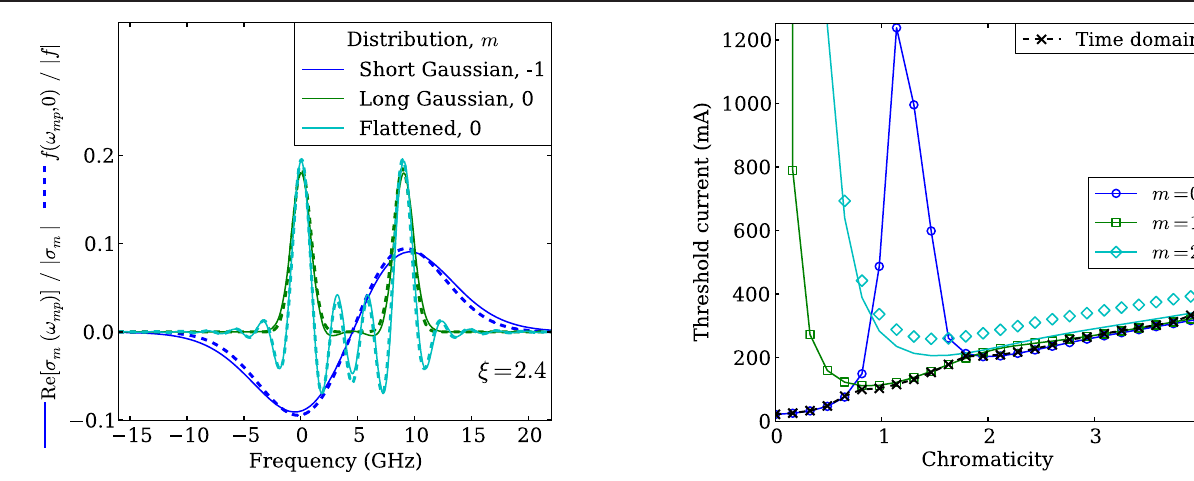
FIG. 14. Comparison of the transverse bunch spectra σ three different beam types at a chromaticity of 2.4 with their corresponding shaker modes excited at zero frequency f ð ω